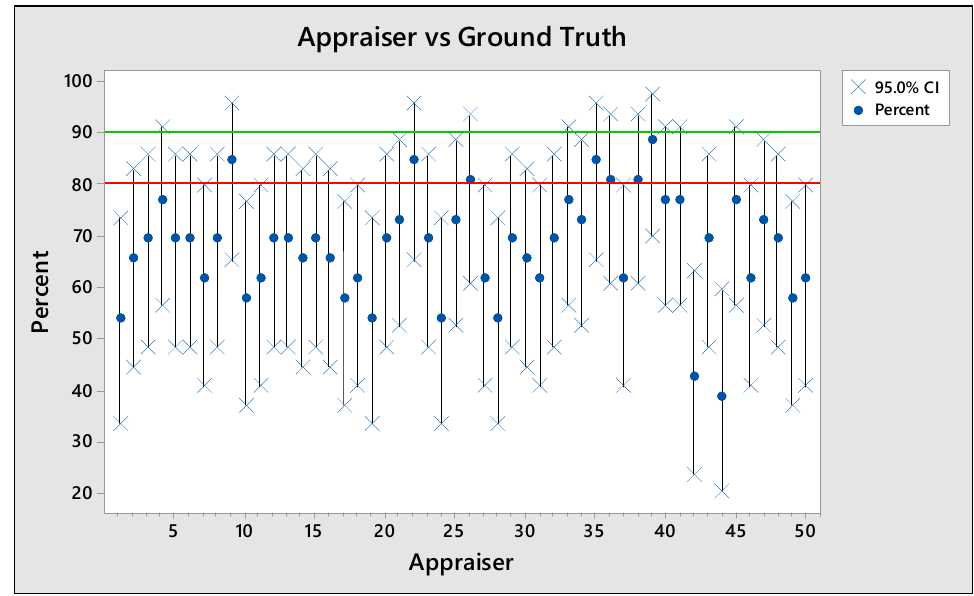
Figure 5. Appraiser agreement with ground truth. There are two agreement thresholds, namely acceptable agreement and excellent agreement indicated by the red and green line respectively. Data for static images only, without the usual ability to view the blade from different perspectives and tactile feeling of the blade.